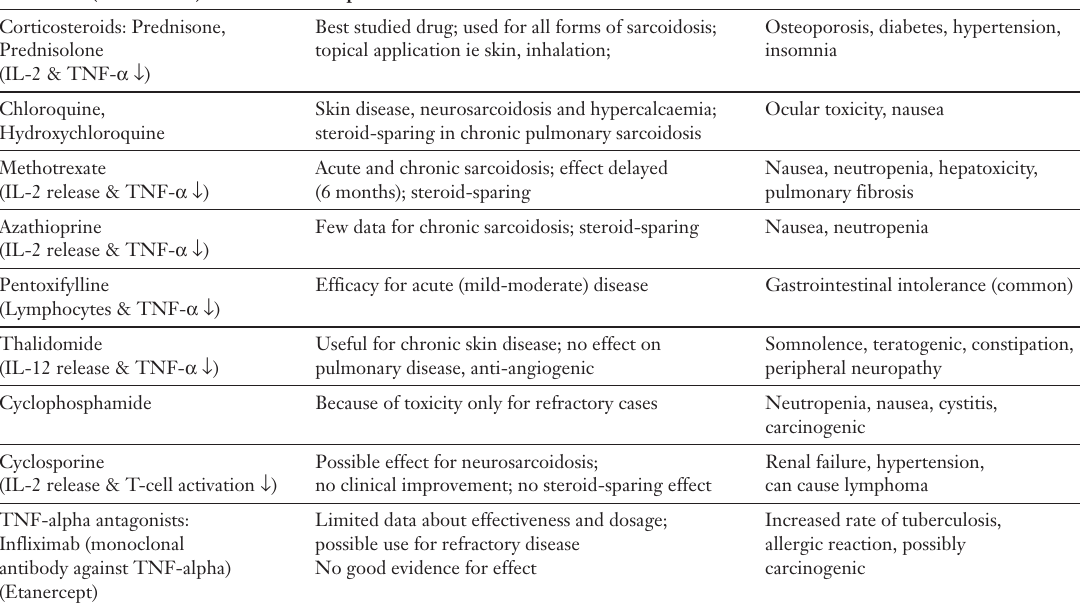
apy. The role for inhalative corticosteroids